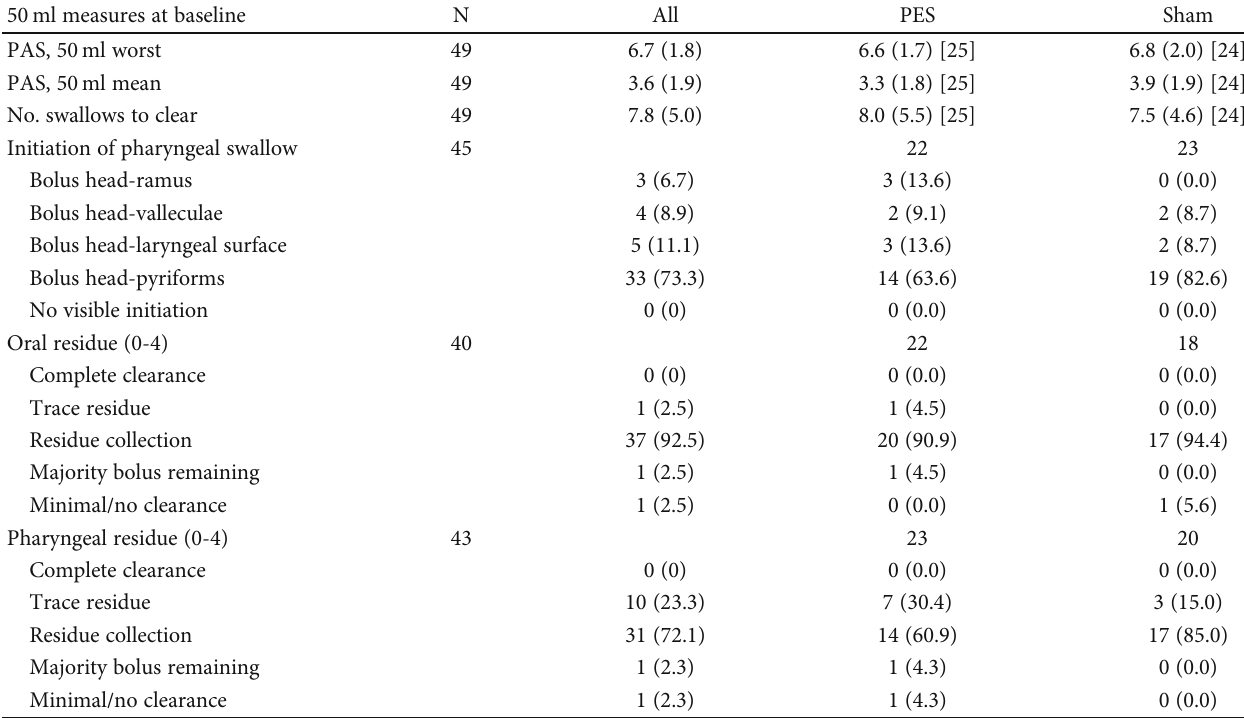
Table 4: VFSS measures at baseline for 50ml bolus (comparison by Chi-square/Fisher ’ s Exact Test or Welch ’ s T -Test (unpooled test).